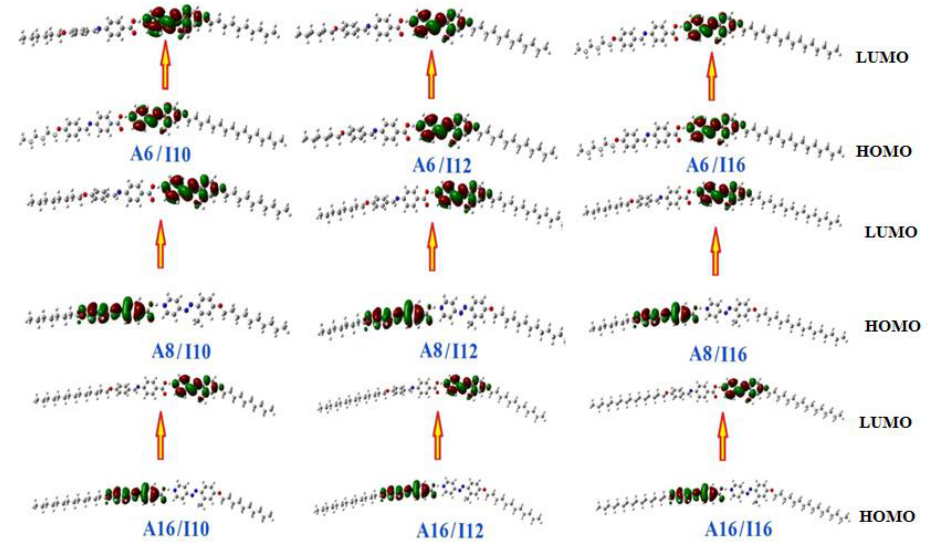
Figure 8. The estimated plots for frontier molecular orbitals of angular-shaped conformer of SMHB complexes, An / Im . Table 4. Frontier molecular orbitals (FMO) Energies a.u., polarizability, α , and dipole moment µ (Debye) of geometrical conformers of HBSMCs, An / Im .